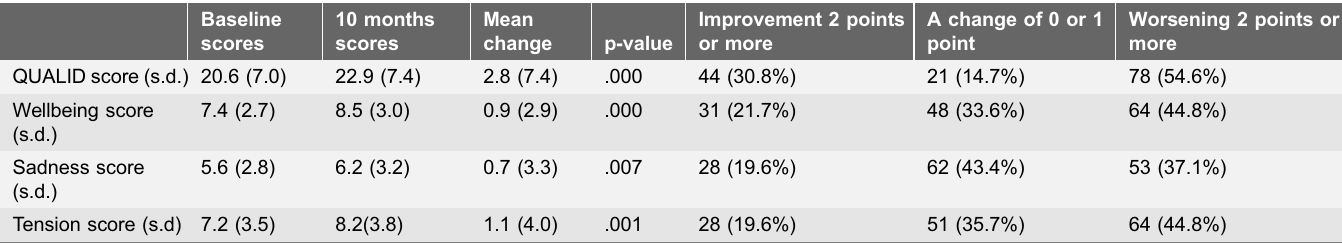
Table 2. The total QUALID score and the subscale QUALID scores at baseline and 10 months follow-up for the patients with observations at both time periods (N 5 143). Baseline